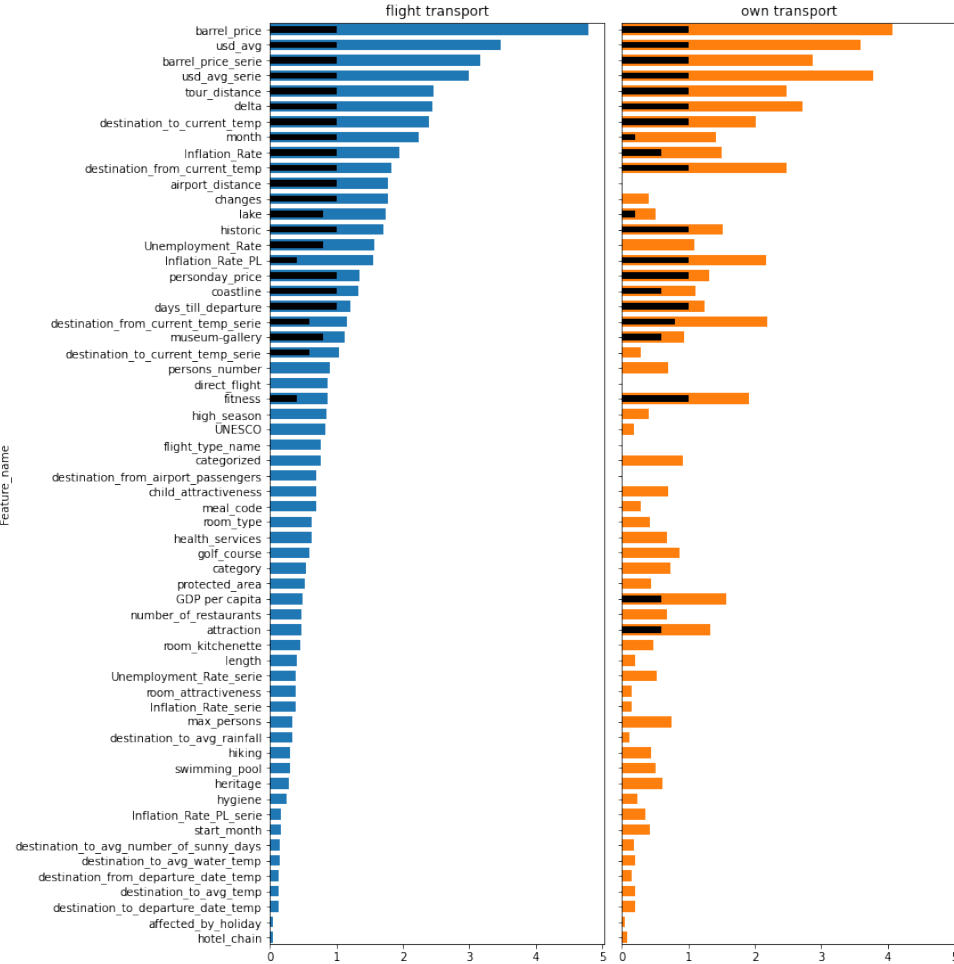
Figure 8. Final evaluation of features for n = 7. Blue and orange bars present the sum of the weights obtained by all five methods. Black bars indicate the result obtained using sequential backward